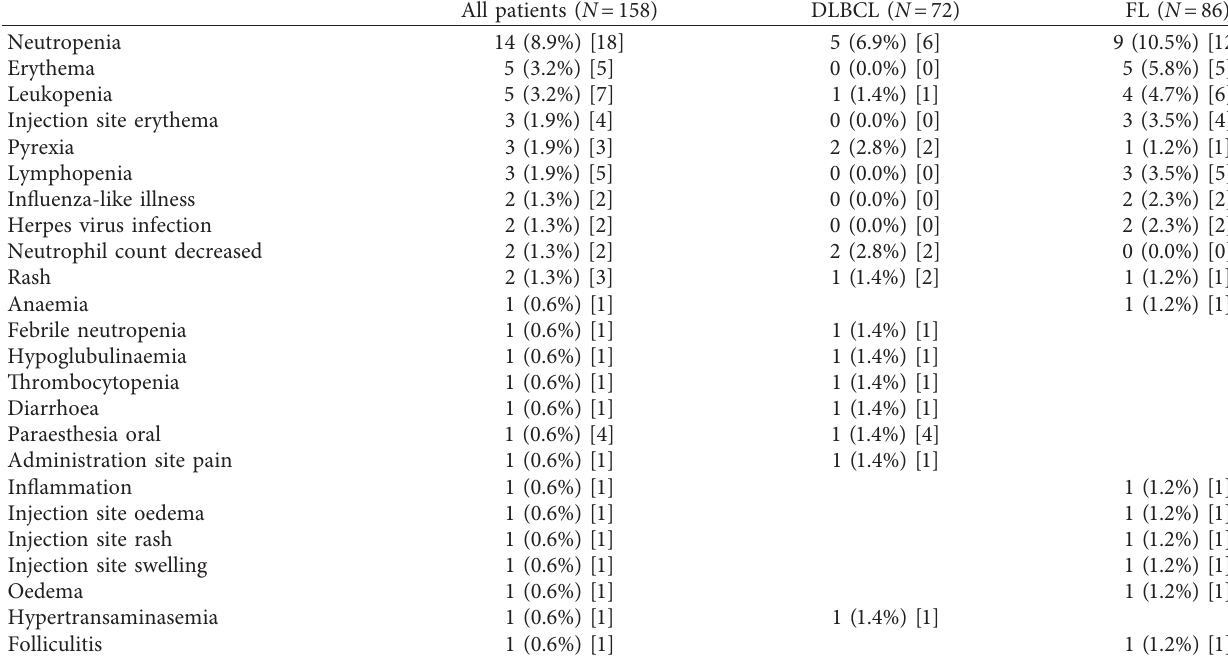
Table 4: Treatment-related TEAEs by preferred term. Data are number (%) of patients [number of events]. All patients ( N � 158) DLBCL ( N �